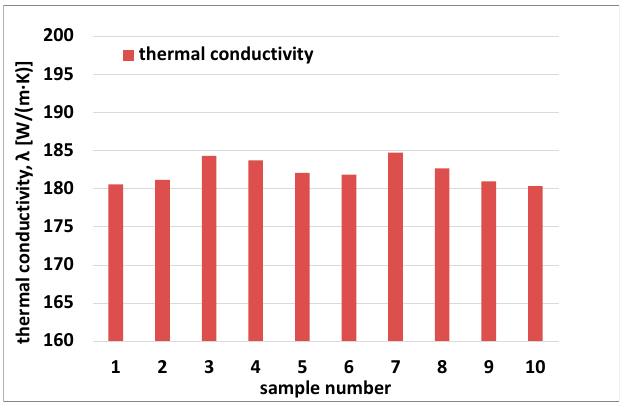
Figure 13. Calculated thermal conductivity λ of 10 samples.